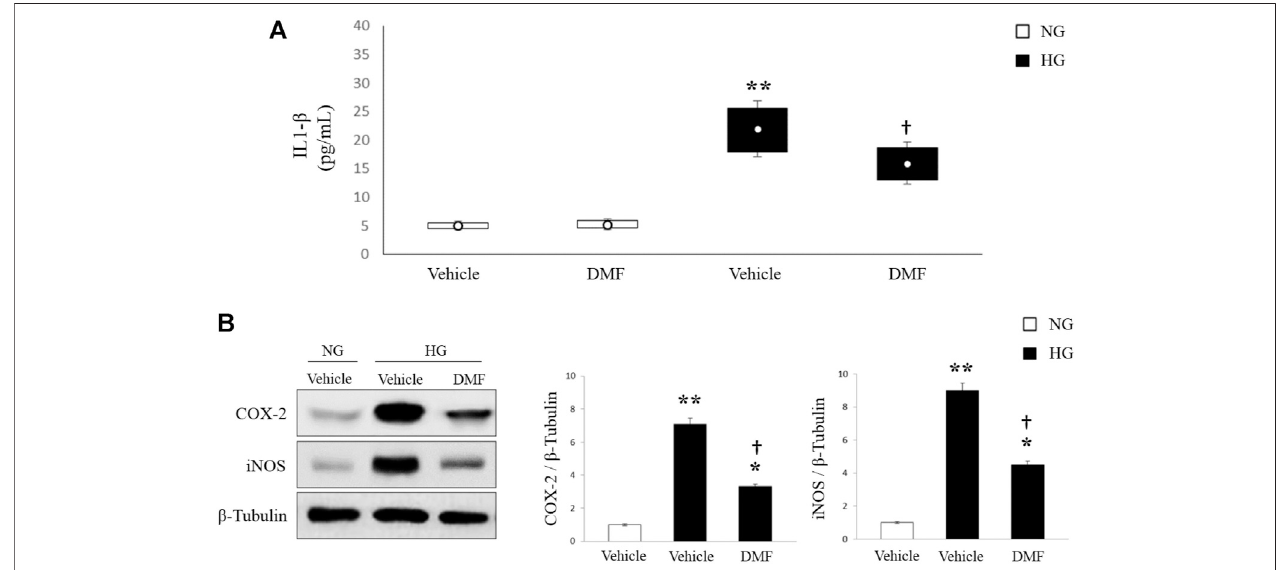
FIGURE 2 | Effects of DMF on in fl ammatory cascade of ARPE-19 cells. ARPE-19 cells exposed to normal glucose (NG) or high glucose (HG) w/or w/o DMF for 24 h. (A ) IL-1ß production was measured through ELISA. ( n (cid:2) 6, ** p < 0.01 vs. Vehicle/NG; † p < 0.05 vs. Vehicle/HG). ( B ) Western blot: COX-2 and iNOS expression proteins. Band densities were quanti fi ed by ImageQuantTL software and normalized values were indicated below each corresponding band. * p < 0.05 or ** p < 0.01 vs. Vehicle/NG; † p < 0.05 vs. Vehicle/HG; n (cid:2) 6.